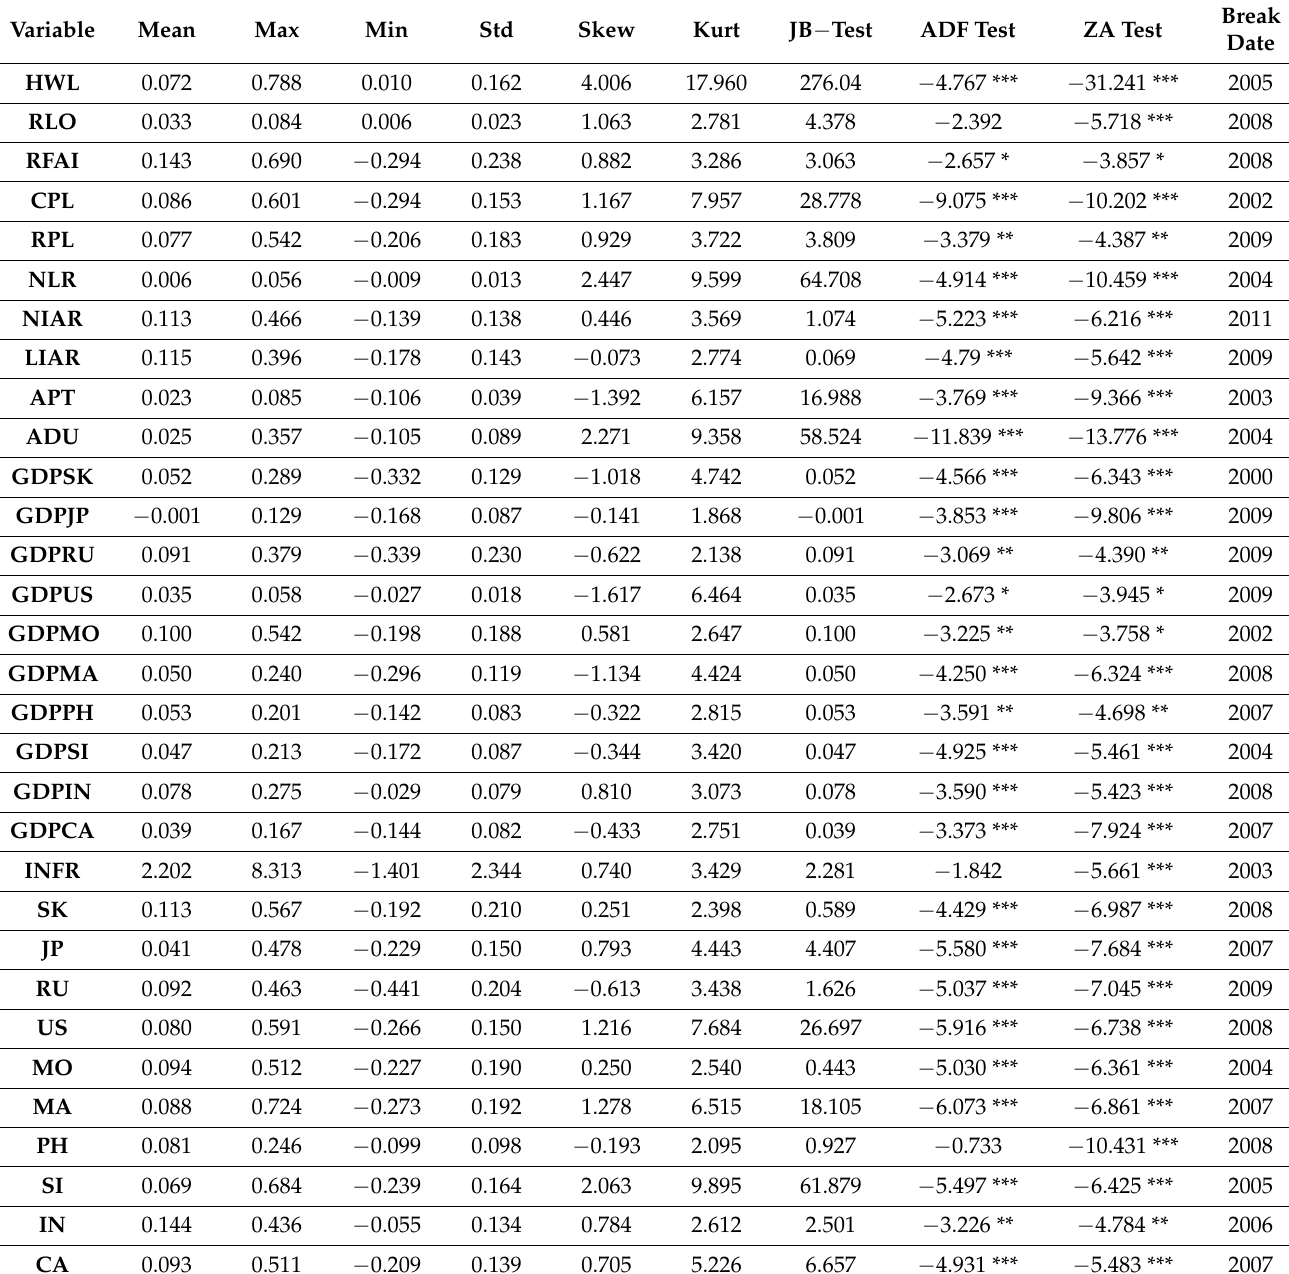
Table 2. Descriptive statistics of